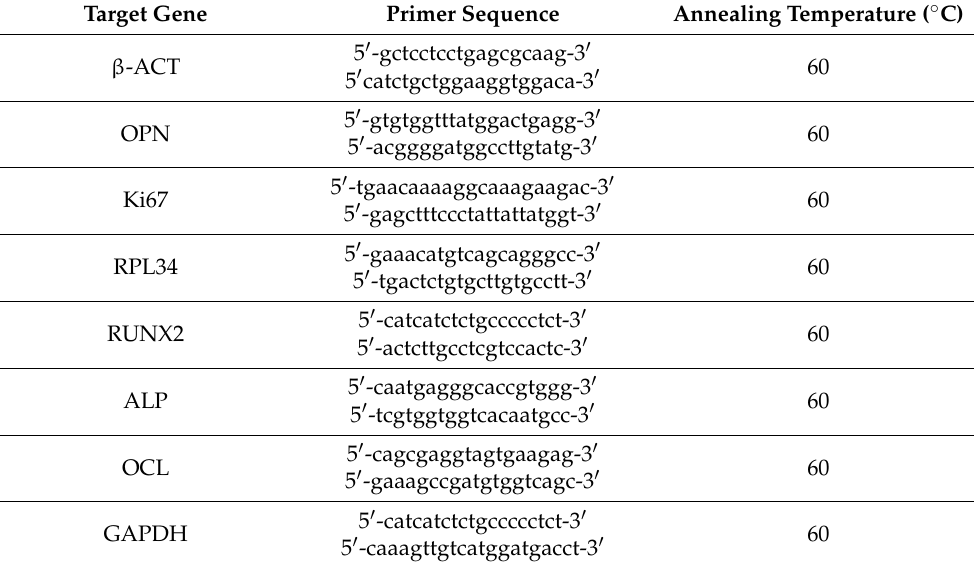
Table 1. Sequence of primers used for